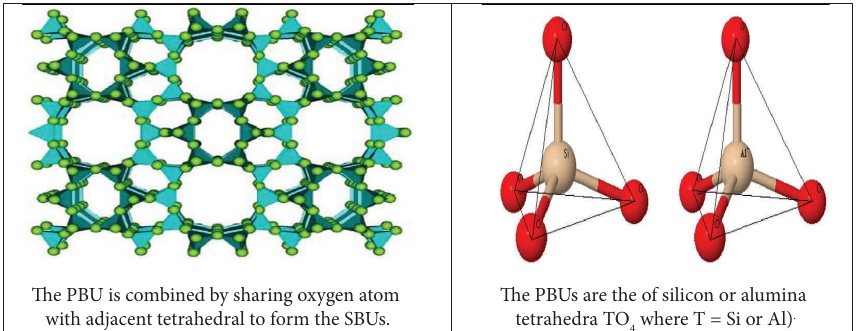
Te PBU is combined by sharing oxygen atom with adjacent tetrahedral to form the SBUs. Figure 4: Primary and secondary building units of zeolites are adopted from [27].